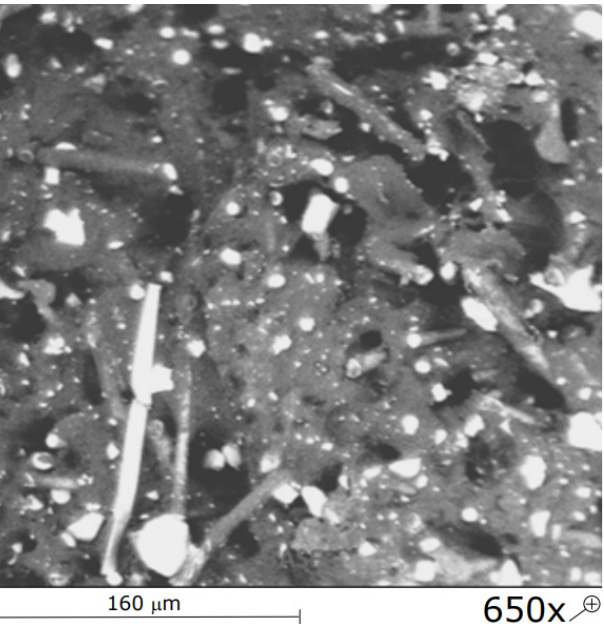
Figure 12. SEM image of a fracture of Ultramid sample exposed to the heat load of 100 °C.